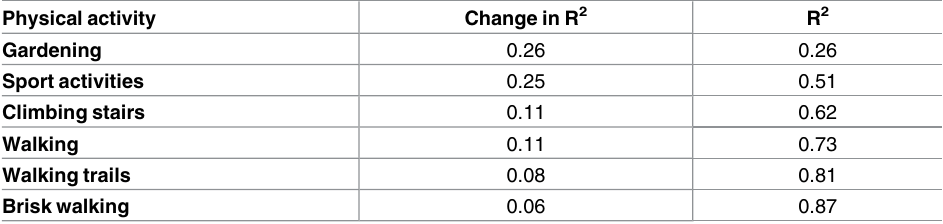
Table 1. Activities explaining most of the variability of physical activity practice at the population level estimated by the Minnesota Leisure Time Physical Activity